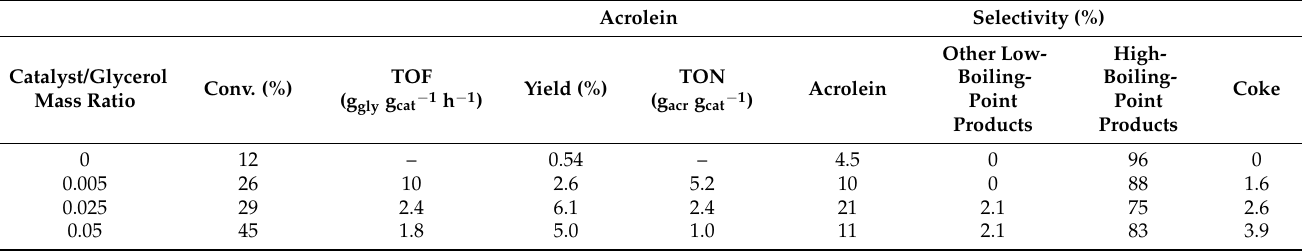
Table 3. Effect of catalyst/glycerol ratio on liquid-phase dehydration of glycerol over ZSM-5_280 a